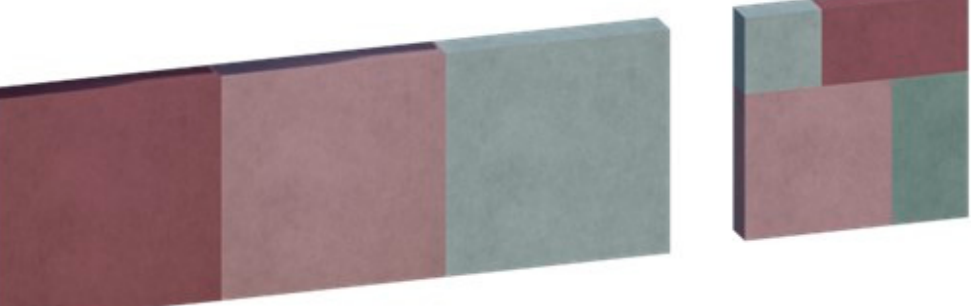
Figure 8. 3D modeling and rendering of the sound-absorbing panel (O100l full and Pattern-B) with pruning wood chips from of olive trees used as the filling material and TNT as the containing mem- brane. Figure 7. ( a ) O100l full configuration; ( b ) O100l full configuration with TNT; ( c ) details of the TNT.